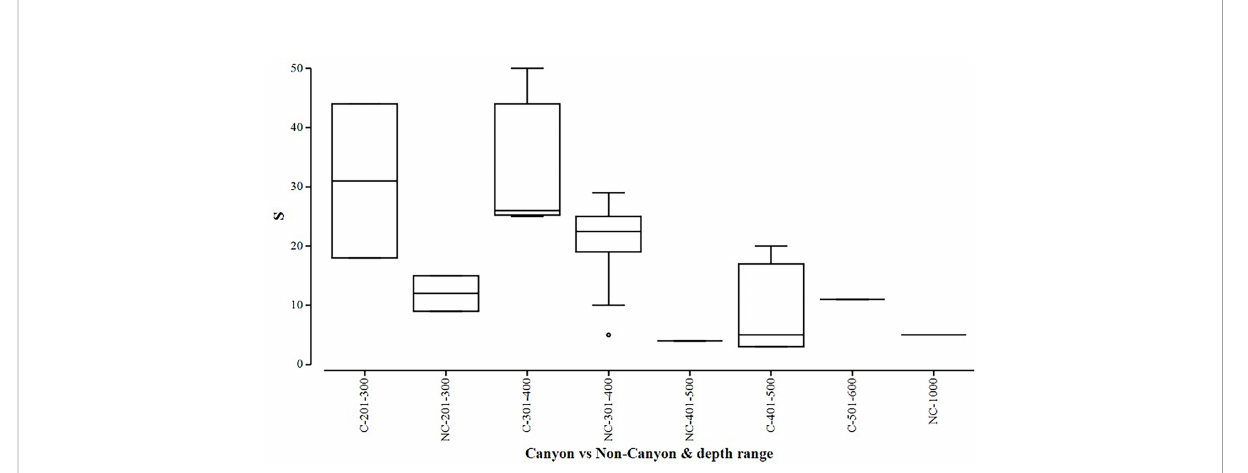
FIGURE 6 Box plot showing species richness (denoted by S) represented within each canyon (C) vs. non-canyon (NC) depth class within the range of 201- 1000 m.